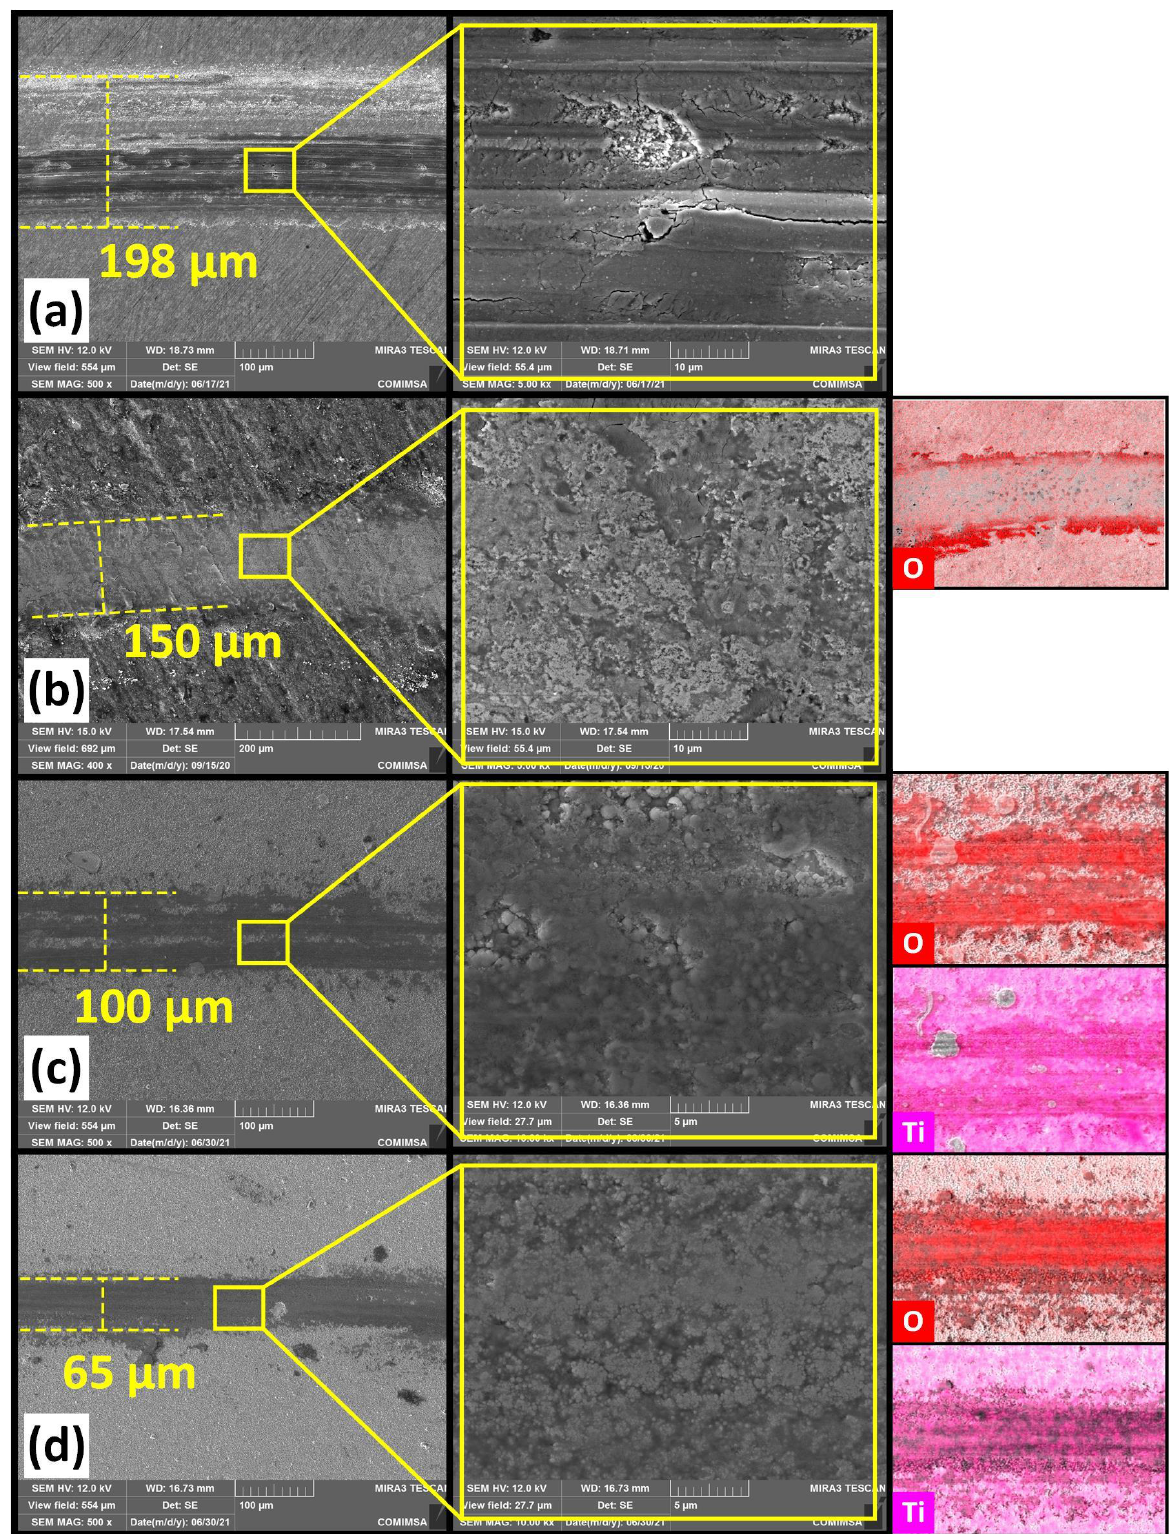
Figure 8. SEM images along with corresponding elemental mapping of ( a ) base sample and ( b ) CPN and duplex-treated samples with substrate temperature for TiN deposition at ( c ) 400 °C and ( d ) 450 °C.